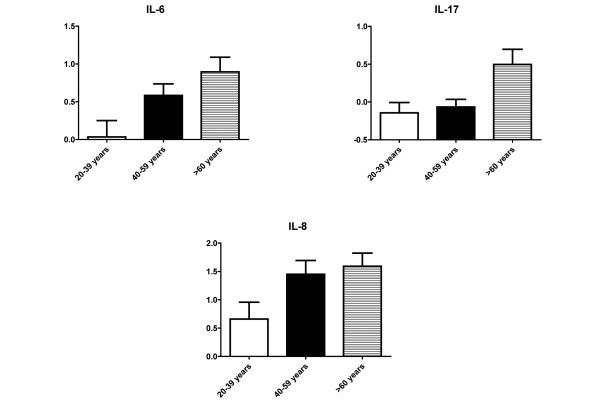
Age effects on plasma cytokine levels.  IL-6 (P = 0.02) and IL-17 (P = 0.01) levels increased with advancing age. There was also a trend for increasing levels of IL-8 with age (P = 0.07). Plasma cytokine levels (in pg/ml) were logn-transformed. Data presented as mean ± standard error of the mean.